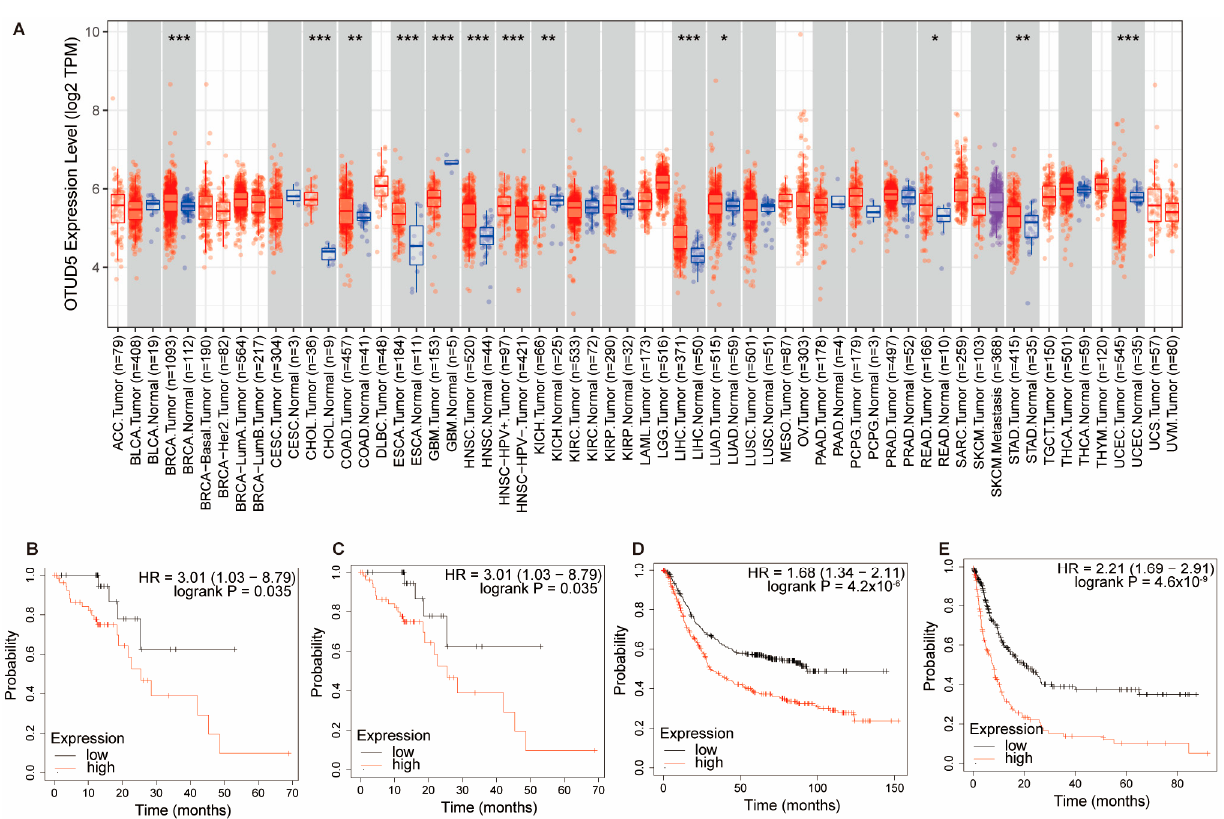
Figure 4. OTUD5 is aberrantly expressed in several types of tumors. ( A ) By analyzing the data in the TCGA database, we found that OTUD5 expression was significantly lower in glioblastoma (GBM), kidney chromophobe (KICH) and uterine corpus endometrial carcinoma (UCEC) and significantly highly expressed in breast cancer (BRCA), bile duct cancer (CHOL), colon cancer (COAD), esophageal cancer (ESCA), head and neck cancer (HNSC), liver cancer (LIHC), lung adenocarcinoma (LUAD), rectal cancer (READ) and stomach cancer (STAD). Data were analyzed using TIMER2.0. p < 0.05 *, p < 0.01 **, p < 0.001 ***. ( B ) The overall survival (OS) of OTUD5 in esophageal cancer (ESCA). ( C ) The recurrence-free survival (RFS) of OTUD5 in esophageal cancer (ESCA). High mRNA expression of OTUD5 was significantly associated with poor OS and RFS in ESCA. ( D , E ) The OS and progression- free survival (PFS) of OTUD5 in stomach cancer (STAD). High mRNA expression of OTUD5 was significantly associated with OS and PFS in STAD. ( B – E ) Data were analyzed using the Kaplan–Meier Plotter, a web-based survival analysis